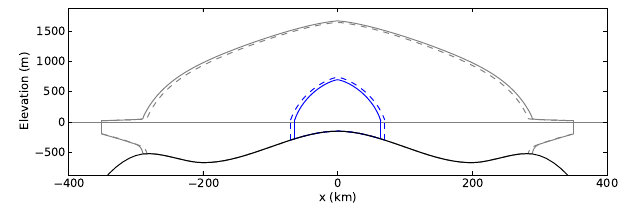
Figure 3. Steady-state ice-sheet profiles for cross section along the centerline ( y = 0) of the three-dimensional channel setup for sim- (continuous) and 3-D ref (dashed). Ini- ulations 3-D ,β = 1 ,γ = 1 α = 1 2 2 tial steady-state before perturbation in grey and final steady-state in blue. Output of the reference simulation is scaled by 0.5 in both horizontal and vertical direction to allow for comparison of shapes between the two simulations.